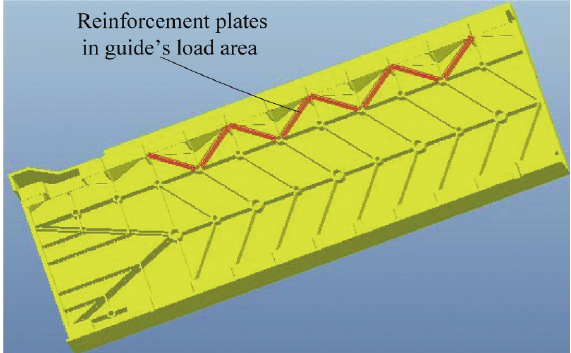
Fig. 6. The bionic type column B.